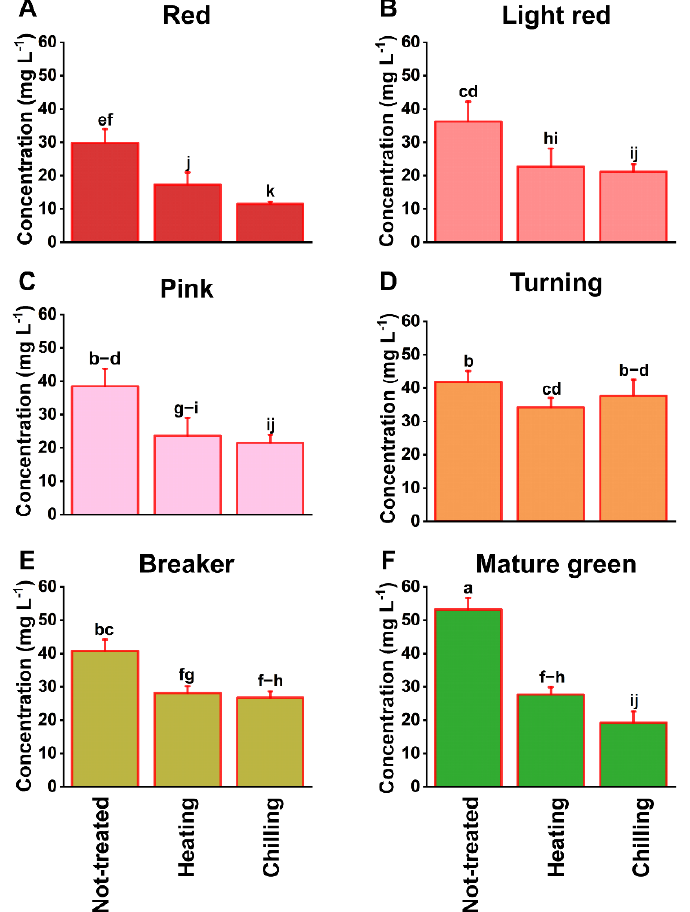
Figure 3. Effect of postharvest temperature treatments on the concentration of flavor compounds (mg L − 1 ) in ripe tomatoes harvested at six maturities: ( A ) red, ( B ) light red, ( C ) pink, ( D ) turning, ( E ) breaker, and ( F ) mature green. Each value is the mean of five replicates of three fruits each. Vertical bars represent the standard deviation of the means. The effect of “maturity × treatment” interaction was tested by two-way ANOVA ( p < 0.05). Different letters on the top of columns represent significant differences between maturity × treatments combined using the Duncan’s multiple range test based on the interaction ( p < 0.05).